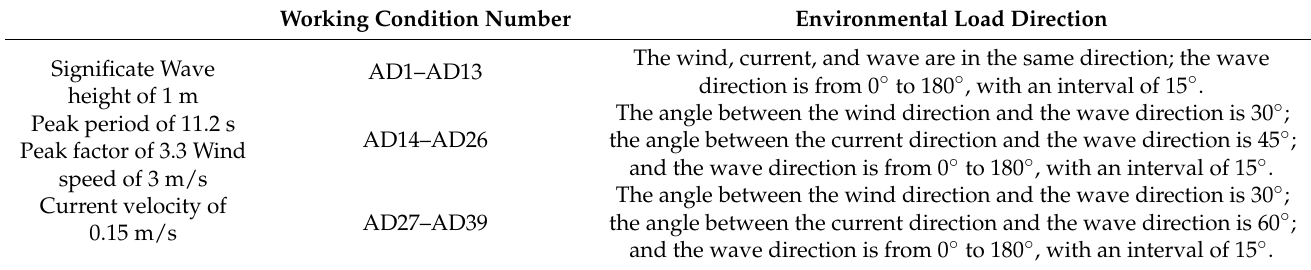
Table 5. Description of Case 2.